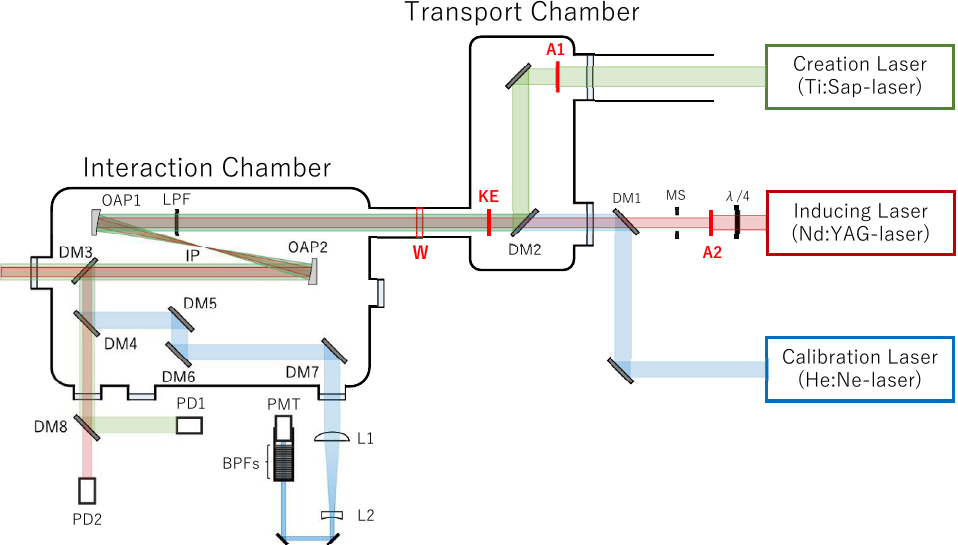
Figure 5 . Experimental setup for this work. The basic design is the same as that in the previous search [11]. The propagations of individual lasers (creation laser, inducing laser, and calibration laser) are painted with green, red, and blue stripes, respectively. Ti:Sapphire and Nd:YAG lasers were used as the creation and inducing lasers. The calibration laser was a He:Ne laser, and it was used to obtain the acceptance of signal photons propagating from the Interaction point (IP) to the photomultiplier tube (PMT). The two irises (A1 and A2) were introduced in order to change the creation beam diameter and to fix the inducing beam diameter for the measurement of the beam cross-section dependence. Both beam diameters were determined using the knife-edge mechanism (KE). We intentionally introduced the window (W) not only to keep a low pressure value in the interaction chamber but also to enhance the background from optical-element aFWM, and to es- tablish the method for discriminating against optical-element